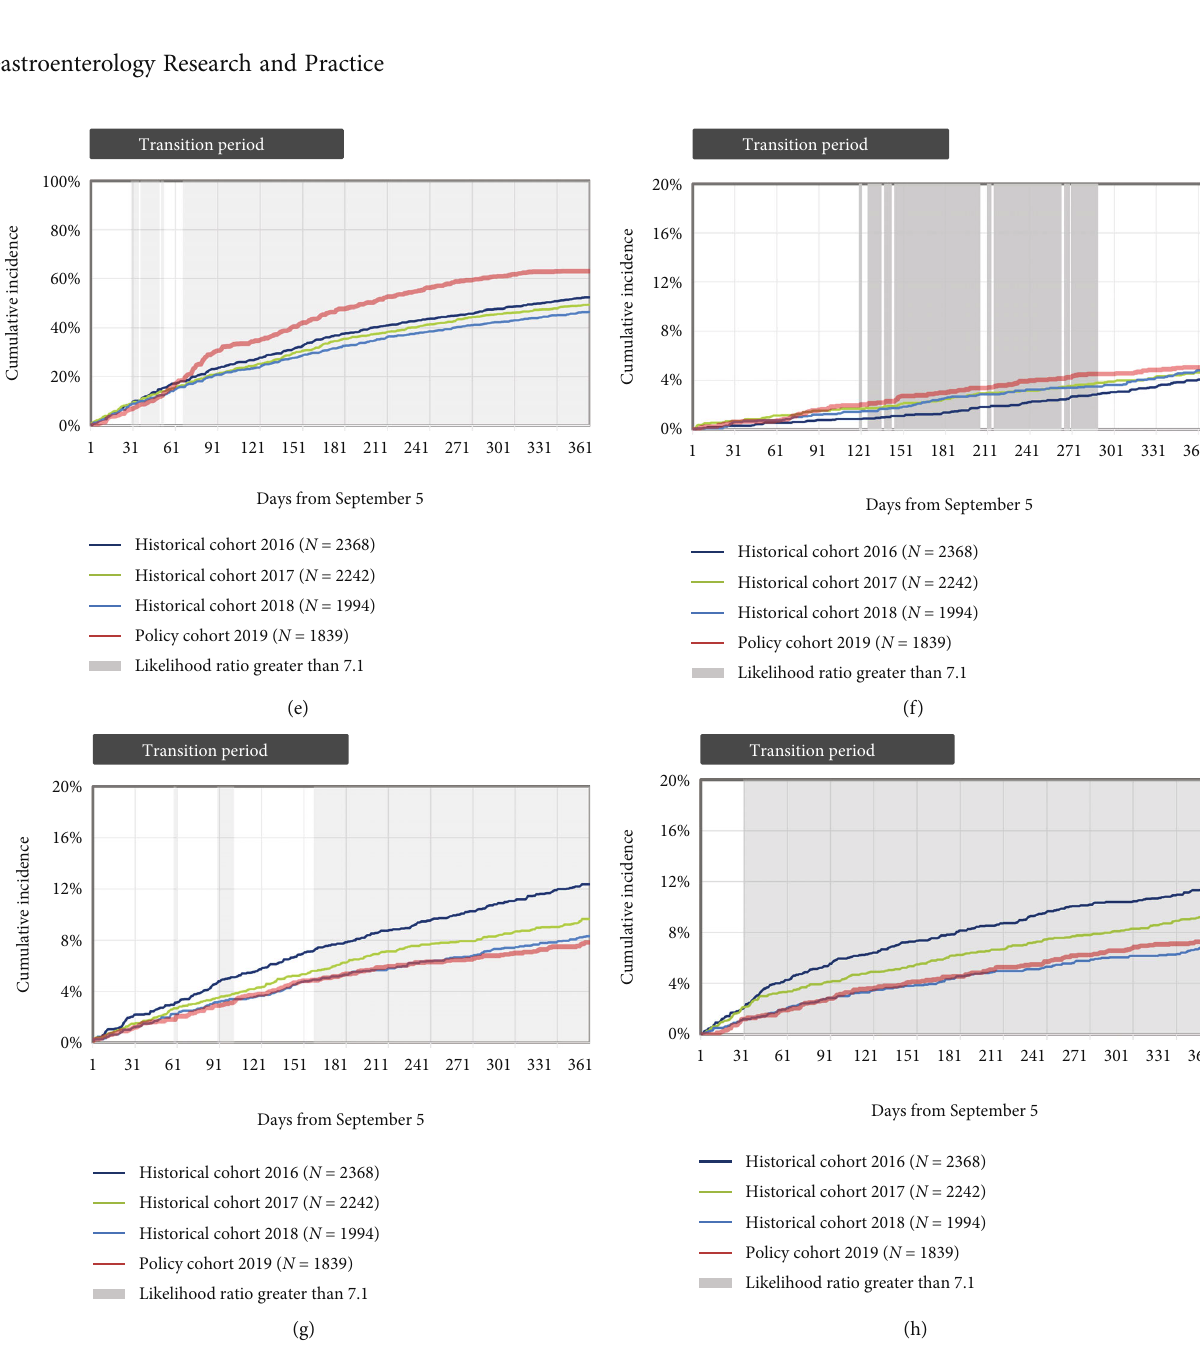
Figure 3: Cumulative incidence of medication outcomes, comparing the policy cohort and the three historical cohorts, for patients of all ages who were treated with in fl iximab for in fl ammatory bowel diseases. The medication outcomes are: (a) fi rst dispensation of in fl iximab (originator or biosimilar) during the 1-year follow-up; (b) second dispensation of in fl iximab; (c) third dispensation of in fl iximab; (d) fourth dispensation of in fl iximab; (e) fi rst event of in fl iximab (originator or biosimilar) dose escalation, de fi ned as a 25% or greater increase in daily dose for the current prescription compared to the average of earlier dispensations; (f) fi rst dispensation event of a di ff erent biologic anti-in fl ammatory medication (switching); (g) fi rst dispensation event of antibiotic medication (metronidazole, cipro fl oxacin); (h) new use of prednisone, de fi ned as the absence of days supply of any systemic corticosteroid in the 6 months before the dispensing of prednisone. Daily likelihood ratios compared the cumulative incidence in the policy cohort to the average among the historical cohorts. A signal of an impact of the policy was de fi ned as likelihood ratios greater than 7.1 (shaded areas) that were sustained for at least 30 days. A transient e ff ect was de fi ned as a period of high likelihood ratios followed by a period in which the likelihood ratio was less than 7.1 (e.g., plates [b] and [c]). Transition periods are presented for adults, who constituted most of the